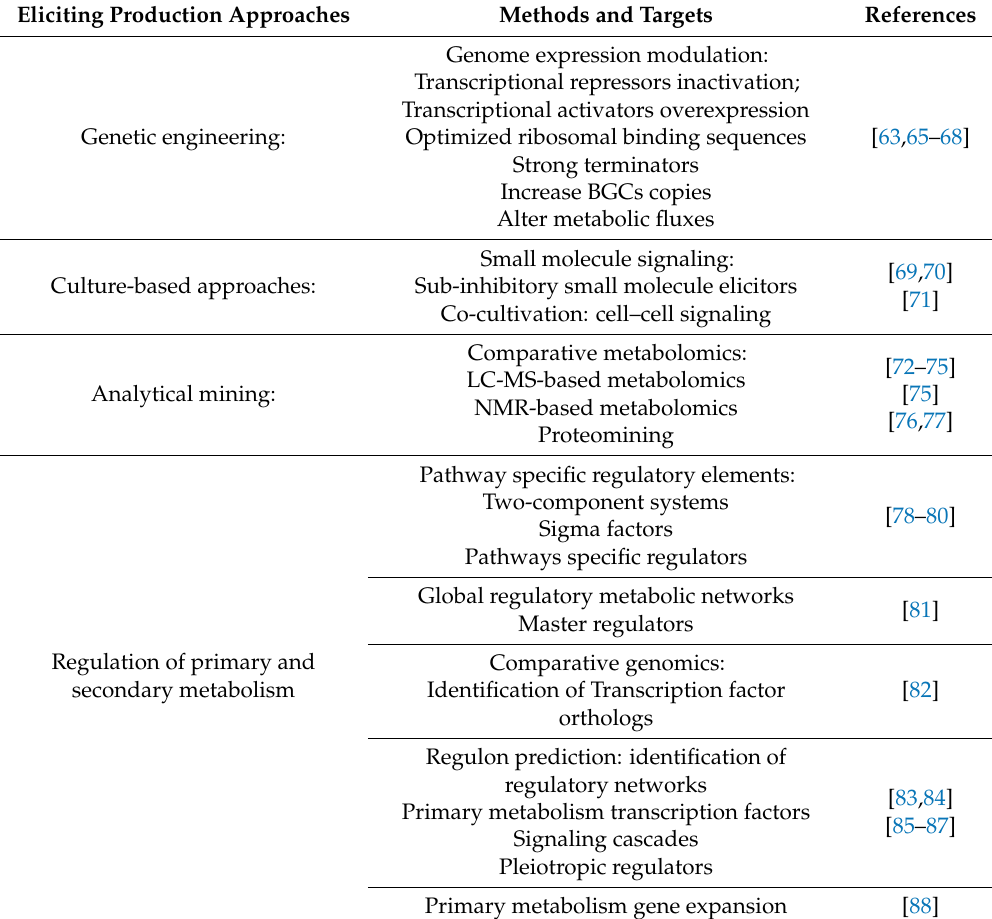
Table 2. Strategies to elicit antibiotic production in